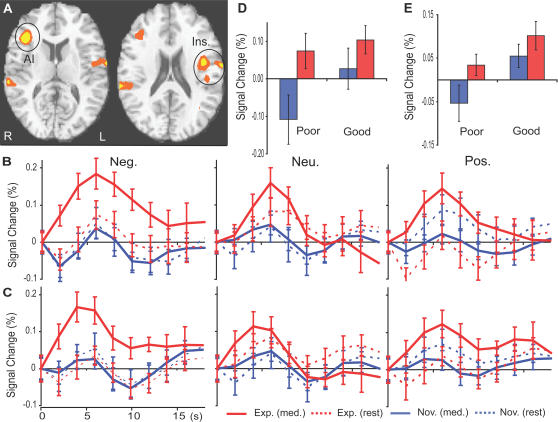
State by Group by valence Interaction: A.(AI) and (Ins.) stand for anterior insula and insula, respectively (z = 12 and z = 19, 15 experts and 15 novices, color codes: orange, p<5.10ˆ-2, yellow, p<2.10ˆ-2). B, C. Impulse response from rest to compassion in response to emotional sounds in AI (B) and Ins. (C). D–E. Responses in AI (D) and Ins. (E) during poor and good blocks of compassion, as verbally reported, for 12 experts (red) and 10 novices (blue).